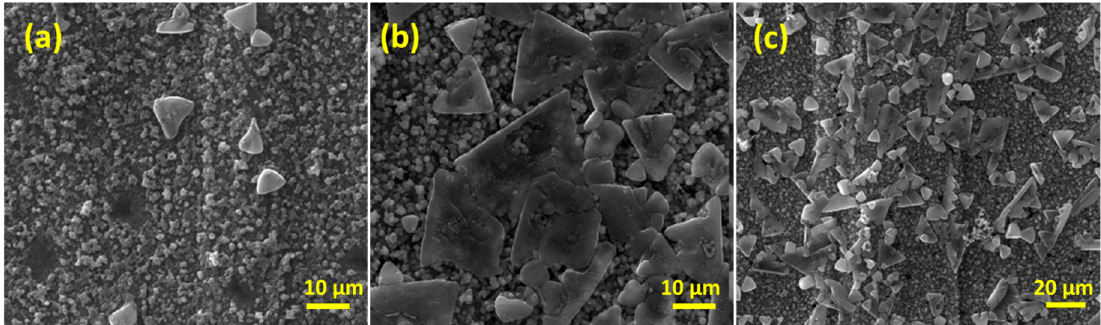
Figure 4. SEM images for a restructured Cu foil (as in Figure 2) galvanically replaced with gold via immersion in an aqueous solution of HAuCl 4 for ( a ) 1 min, ( b ) 3 min and ( c ) 5 min.